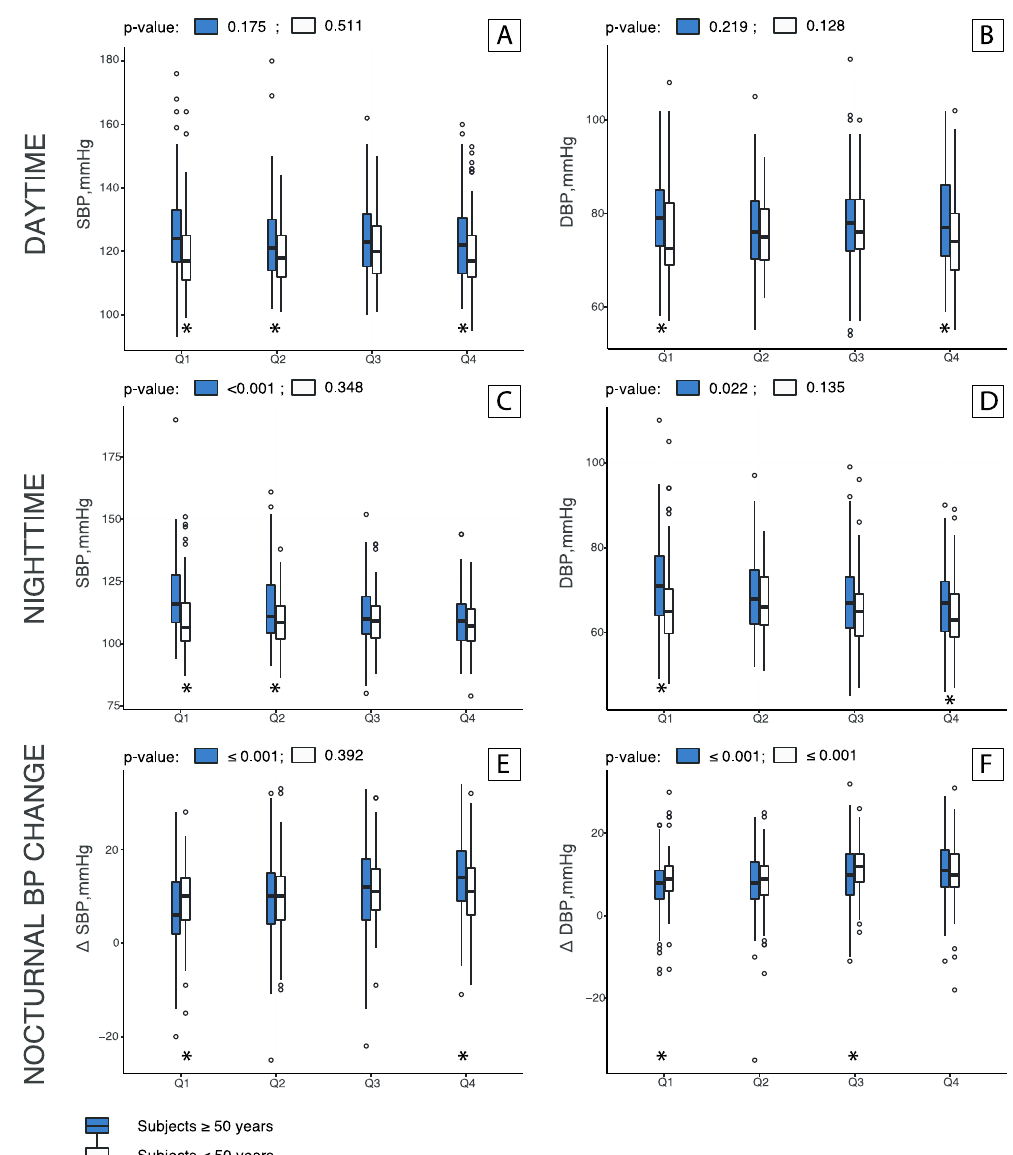
Figure 1. Daytime ( A , B ), Nighttime ( C , D ) and Nocturnal BP change ( E , F ) by age groups among quartiles of daytime/nighttime urinary sodium excretion ratio. Bars represent quartiles of the daytime/nighttime urinary sodium excretion ratio (median and confidence interval). Gray and white bars represent the age groups, respectively, of ≥ 50 years (589 individuals) and <50 years (473 individuals). The x axis shows quartiles (Q1, Q2, Q3 and Q4) of the daytime/nighttime urinary sodium excretion ratio. p values were obtained with a Wilcoxon rank-sum test performed across quartiles and among age groups. * indicate a p -value ≤ 0.05. Nighttime BP and nocturnal dipping values were significantly different across quartiles of daytime/nighttime urinary sodium excretion ratio in the older group ( p -values for nighttime SBP ≤ 0.001, nighttime DBP 0.022, nocturnal SBP dipping ≤ 0.001 and nocturnal DBP dipping ≤ 0.001). No significant differences were found across quartiles for the daytime BP values in both age groups. Moreover, comparing age groups, low daytime excretors (Q1) showed significantly higher BP values in the older group comparing with the younger group for SBP, DBP, for both nighttime values and dipping values (all p -values < 0.05). Significant di ff erences in nighttime MBP and nighttime PP were also found across quartiles in over 50 years (Supplementary Materials Figure